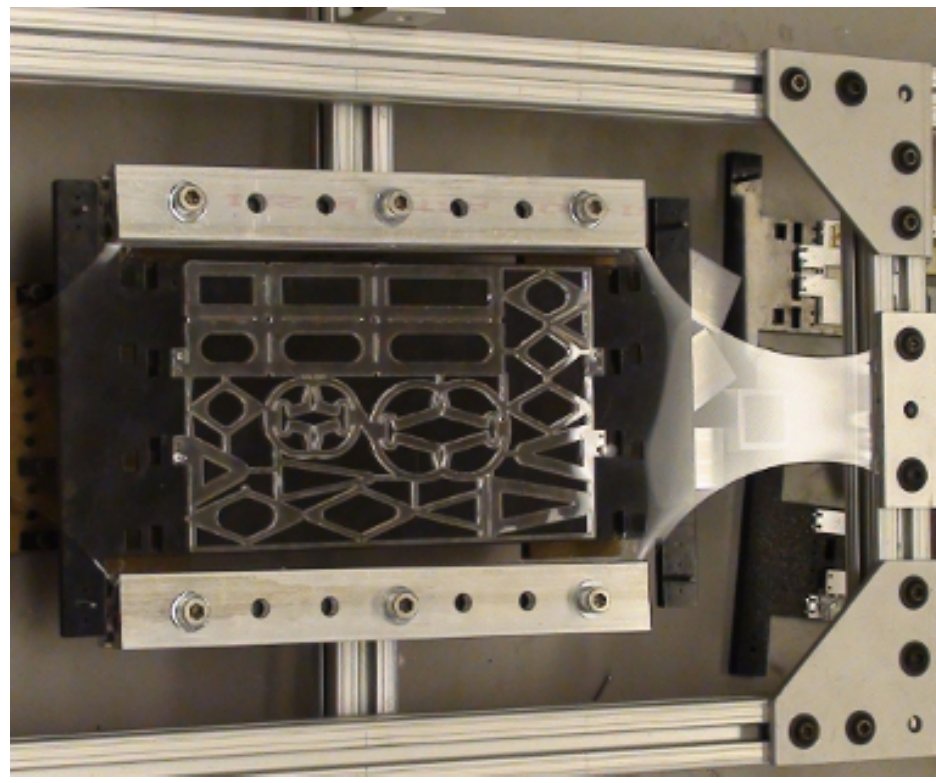
Figure 4. The biaxial stretching device with several device prototype